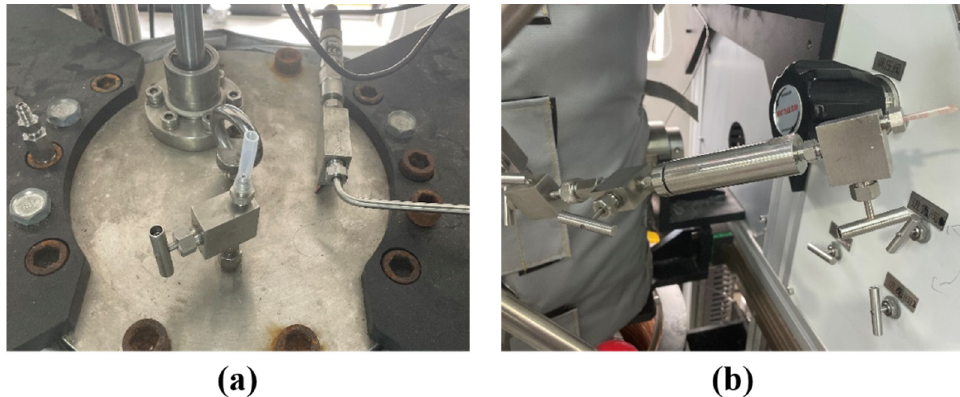
Figure 6. Schematic diagram of ( a ) the top gas sampling port, and ( b ) the liquid sampling port with its corresponding water sampler.